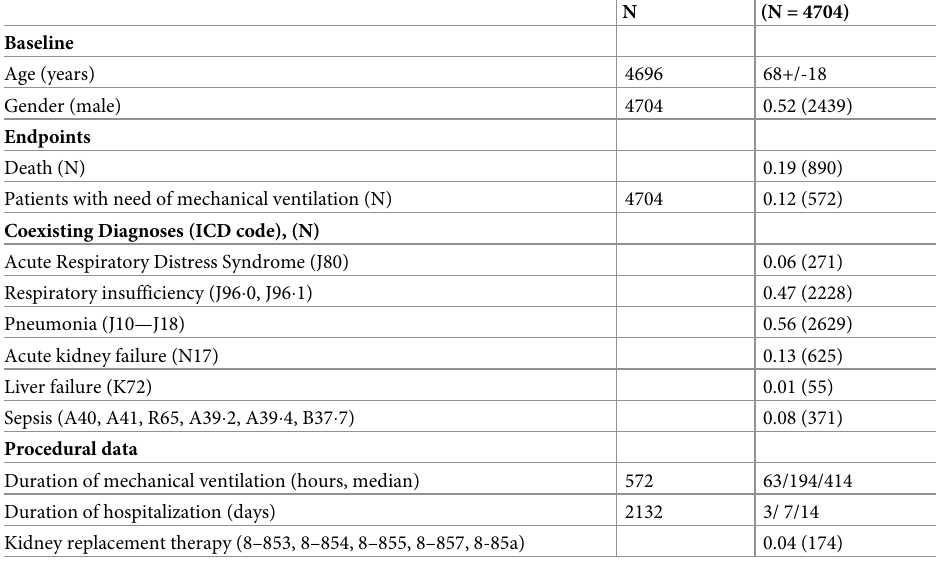
Table 1. Patient characteristics complete study cohort (N = 4704).